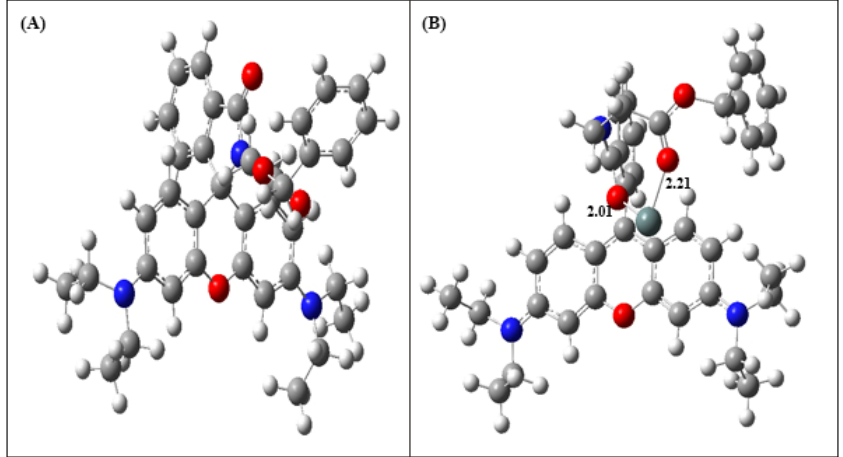
Figure 11. Energy-minimized structure of ( A ) RBAP and the ( B ) RBAP -Sn 2+